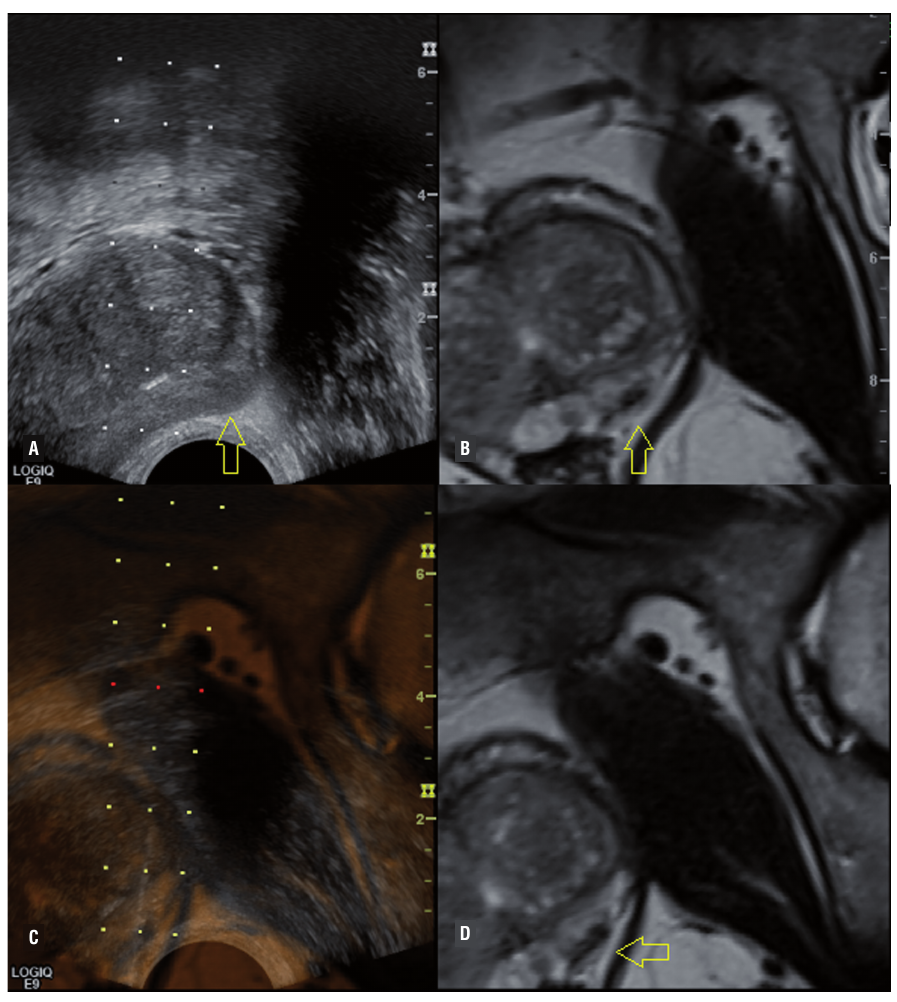
Figure 2 - A suspicious lesion on mpMRI (images B and D) submitted to a US-MRI fusion biopsy. The lesion was not seen on US (arrow in A) and the biopsy was performed based on mpMRI (arrow in C). The biopsy result was Gleason 3+4 in all tree fragments of this